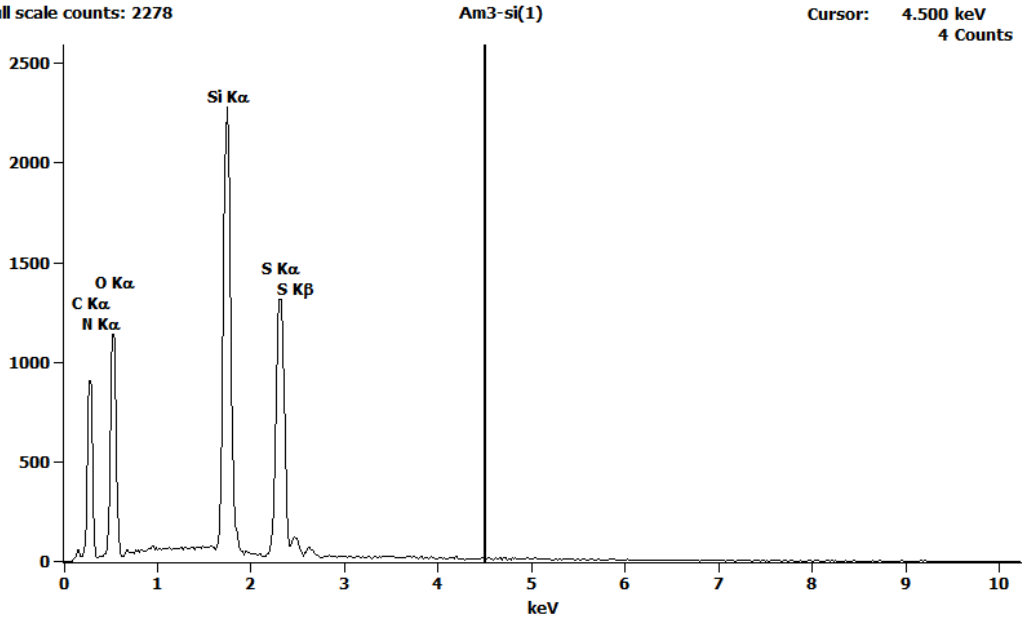
Figure 6. Energy-dispersive X-ray spectroscopy (EDX) spectrum of adsorbent 1 before adsorption .